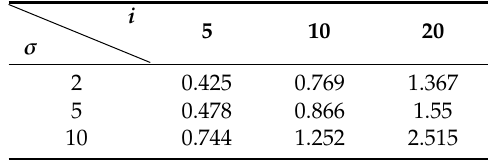
Figure 20. Additional LBF model results. ( a – c ) are the results with parameter values of λ 1 = 1, λ 2 = 2, σ = 2, and i = 5, 10, 20; ( d – f ) are the results with parameter values of λ 1 = 1, λ 2 = 2, σ = 3, and i = 5, 10, 20; and ( g – i ) are the results with parameter values of λ 1 = 1, λ 2 = 1, σ = 2, and i = 5, 10, 20. Table 4. Computing time (s) of LBF model with varying σ .